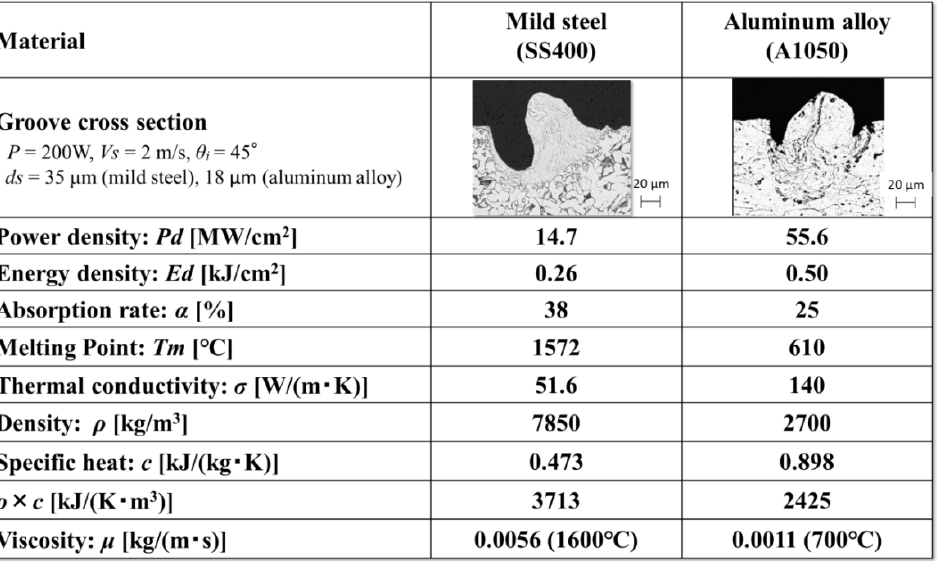
Figure 9. Schematic illustration of molten metal behavior under angled laser irradiation during high- speed scanning (mild steel).